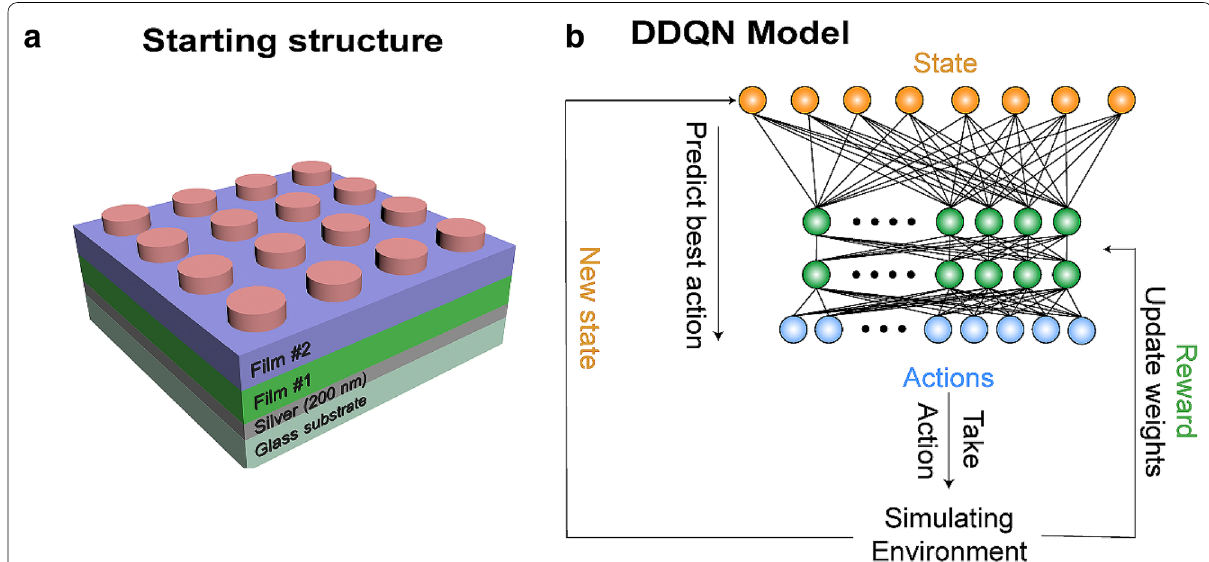
Fig. 1 a A schematic of the structure for the DDQN model to optimize and b the algorithm flowchart of the DDQN